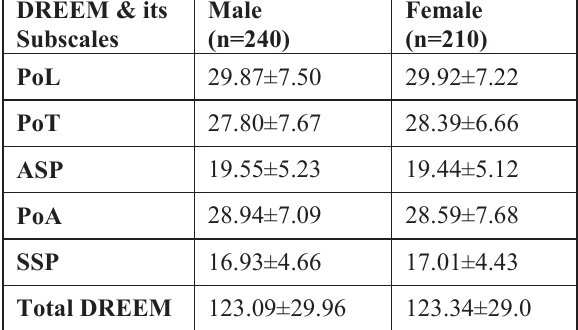
Table-1: Gender wise mean scores of Total DREEM & its Subscales.